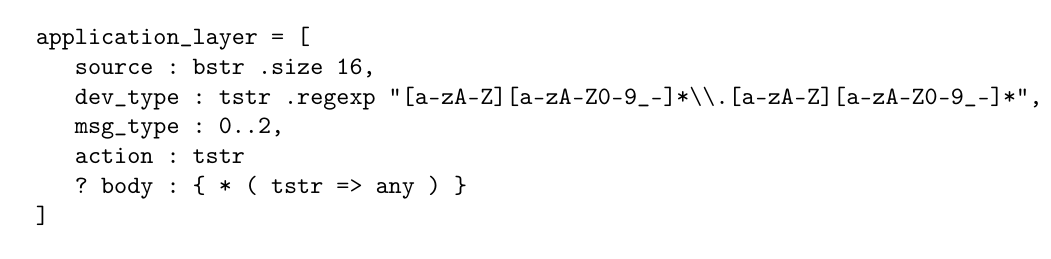
Figure 3. CDDL specification of the xAAL Application